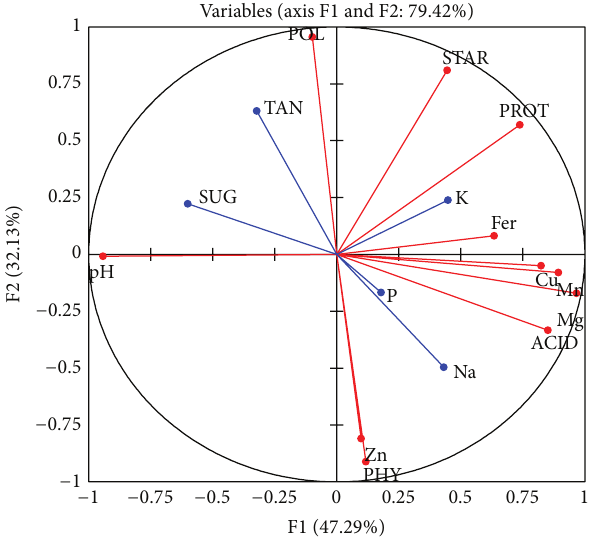
Figure 9: Correlation circle of the variables of Kutukutu in the principal component analysis axis (TAN: tannins; PHY: phytates; POL: polyphenols; PROT: proteins, ACID: lactic acid; STRA: starch; SUG: sugar) analyzed during fermentation of Kutukutu by